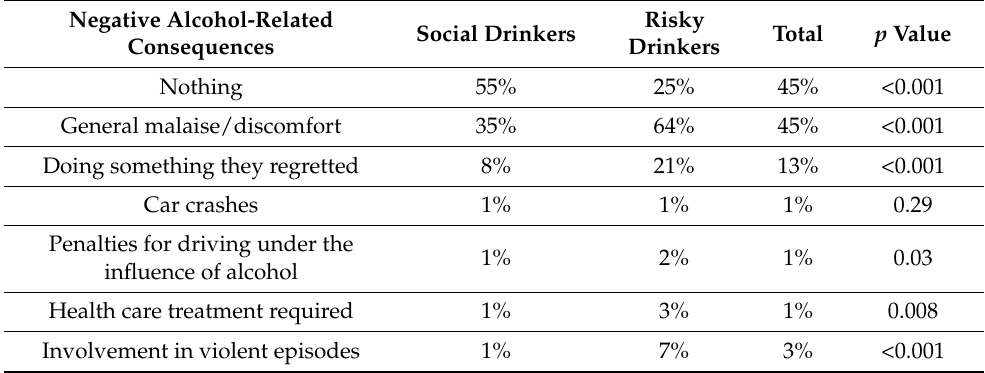
Table 3. Frequencies of reported negative alcohol-related consequences in social and risky drinkers.